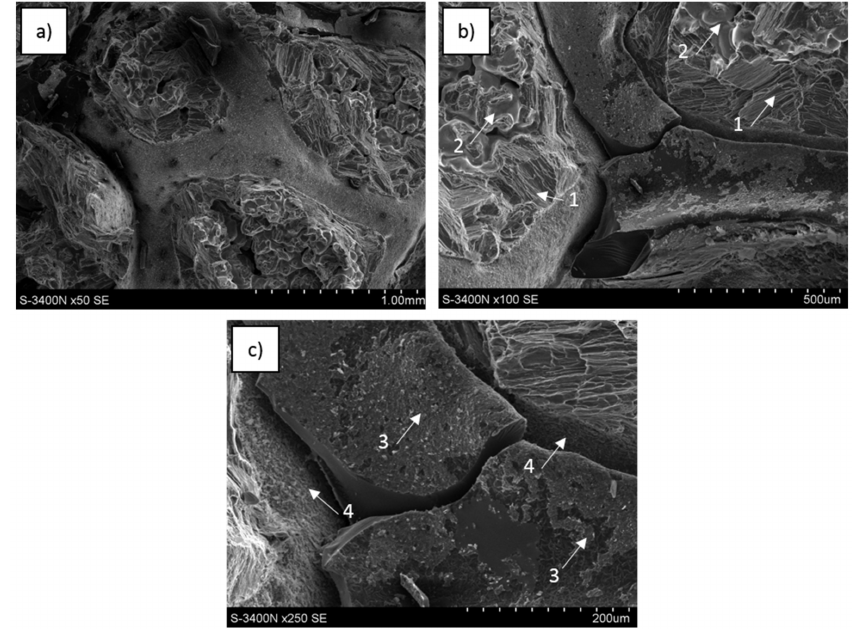
Figure 16. SEM images of C of 45ppi–AZ31 composite fractured during three-point bending strength testing: ( a ) metal cells surrounded with a fractured glassy carbon network, ( b ) di ff erently oriented shear bands (1) and dendrites (2) in metal matrix and fragmented foam, ( c ) surface of delaminated carbon foam and matrix, thin layer of fine phases on C of surface (3), fine phases on matrix surface